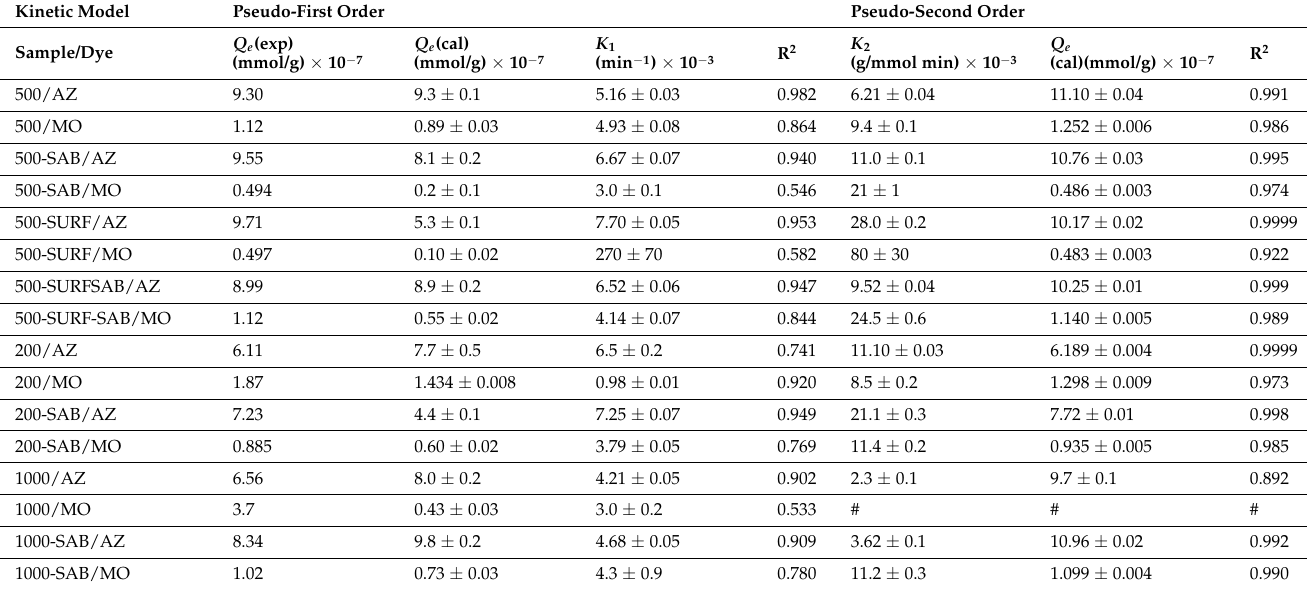
Table 4. Kinetic parameters of the pseudo-first and pseudo-second order models for the adsorption of AZ and MO onto the membranes.